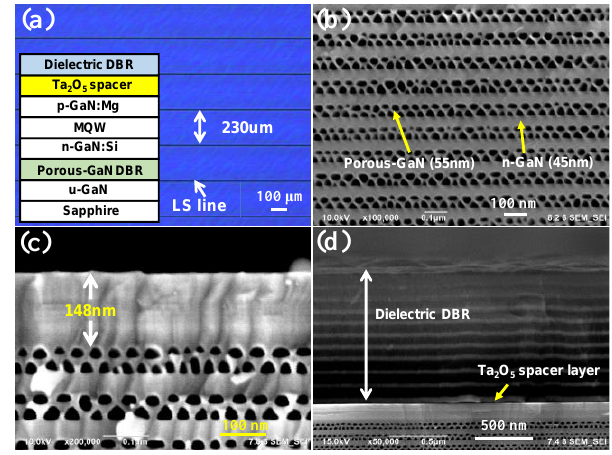
Figure 1. ( a ) The OM image of the InGaN LED with bottom porous-GaN DBR structure was observed with a blue reflected light image. ( b ) The cross-sectional SEM micrograph of the porous- distributed Bragg reflector (DBR) structure was observed. ( c ) A 148 nm thick InGaN LED structure was shown above the porous reflector. ( d ) The top reflector consisted of a 30 nm thick Ta 2 O 5 spacer layer and a top Ta 2 O 5 /SiO 2 DBR structure.